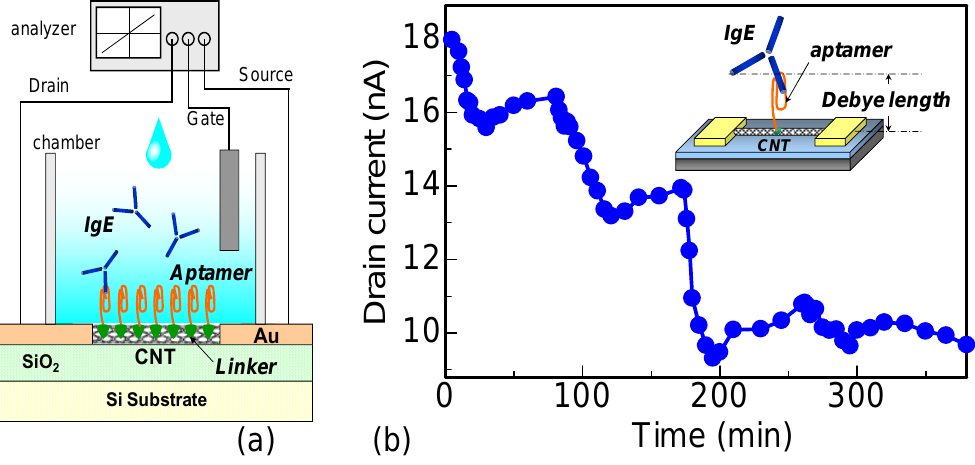
Figure 5. (a) Schematic structure of experimental setup for aptamer-modified CNTFET. (b) Time dependence of drain current in CNTFET after introduction of target IgE at various concentrations into IgE aptamer-modified